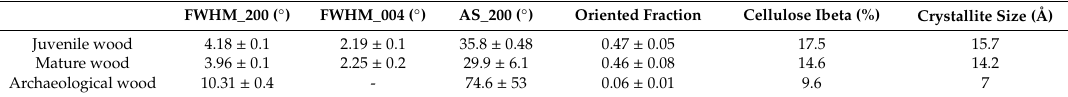
Figure 7. X-ray diffraction analysis. 2D-XRD patterns of juvenile ( A ), mature ( B ), and archaeological ( C ) wood samples. ( D ) 2Theta scans calculated by radially integrating the intensity of 2D-XRD patterns (A–C). Color intensity scale. Table 3. Crystallinity, crystal orientation, and % cellulose I β determined using Rietveld refinement of X-ray diffraction data.